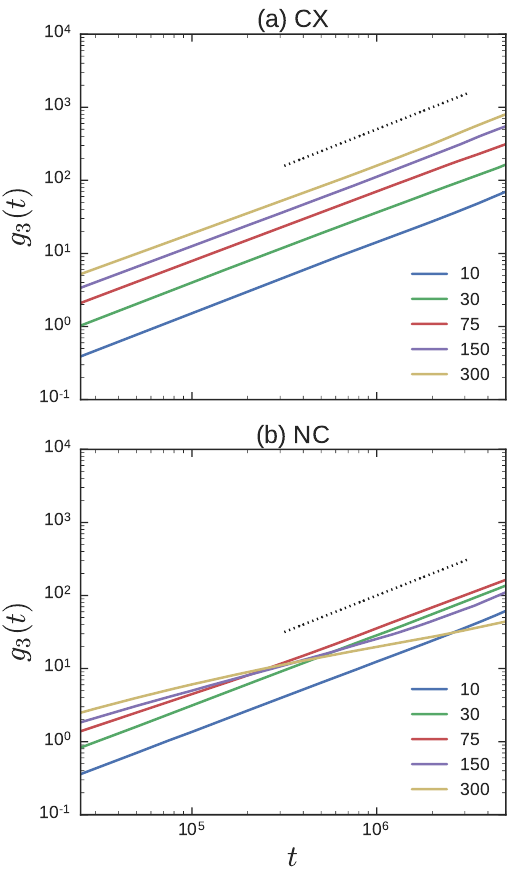
Figure 8. The g 3 ( t ) curves of the probe rings for the ( a ) crossing; and ( b ) non-crossing simulations. Different lines correspond to different N l indicated in the legend. The dotted line in both figures has a slope of